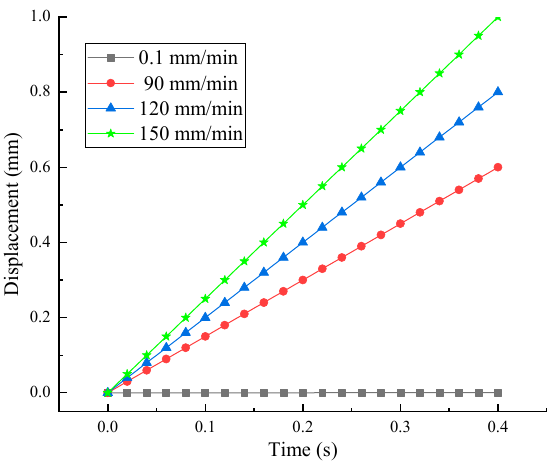
Figure 6. Loading rate profiles of the three-point bending experiments.